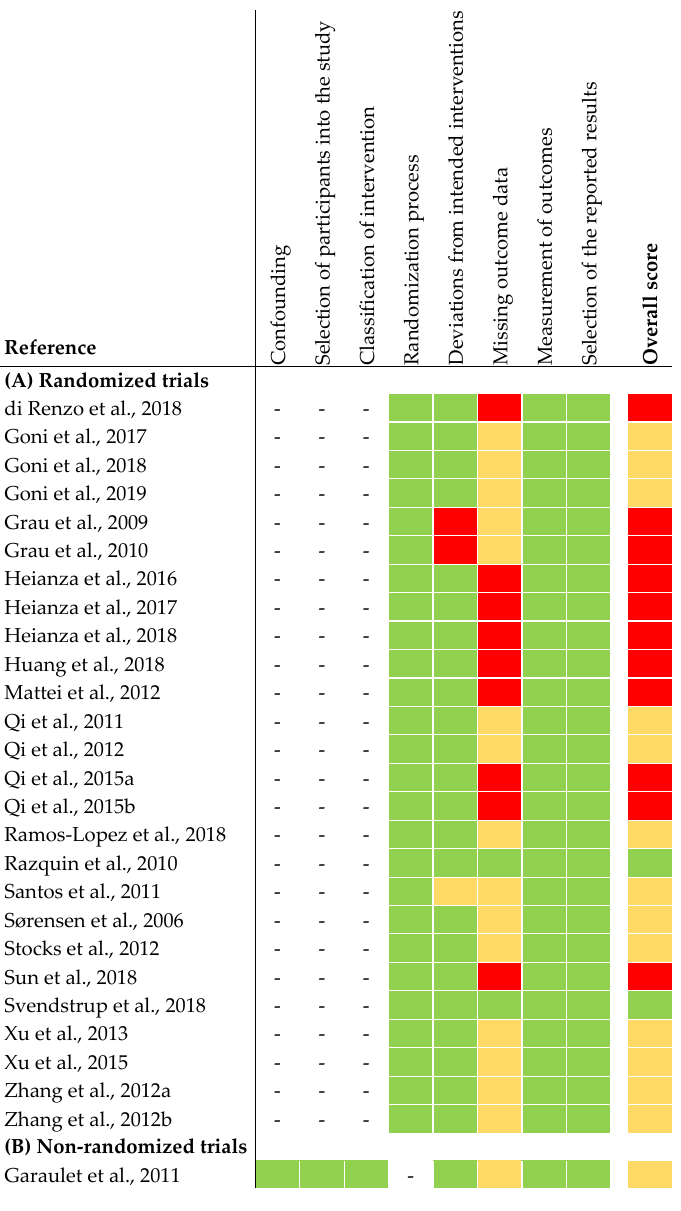
Figure 2. Risk of bias assessment of articles included in narrative synthesis. ( A ) Risk of bias assessment of randomized trials [26] . ( B ) Risk of bias assessment of non-randomized trials [27] . Overall score: the risk of bias was judged as low risk (green), some concerns (yellow), high risk (red).